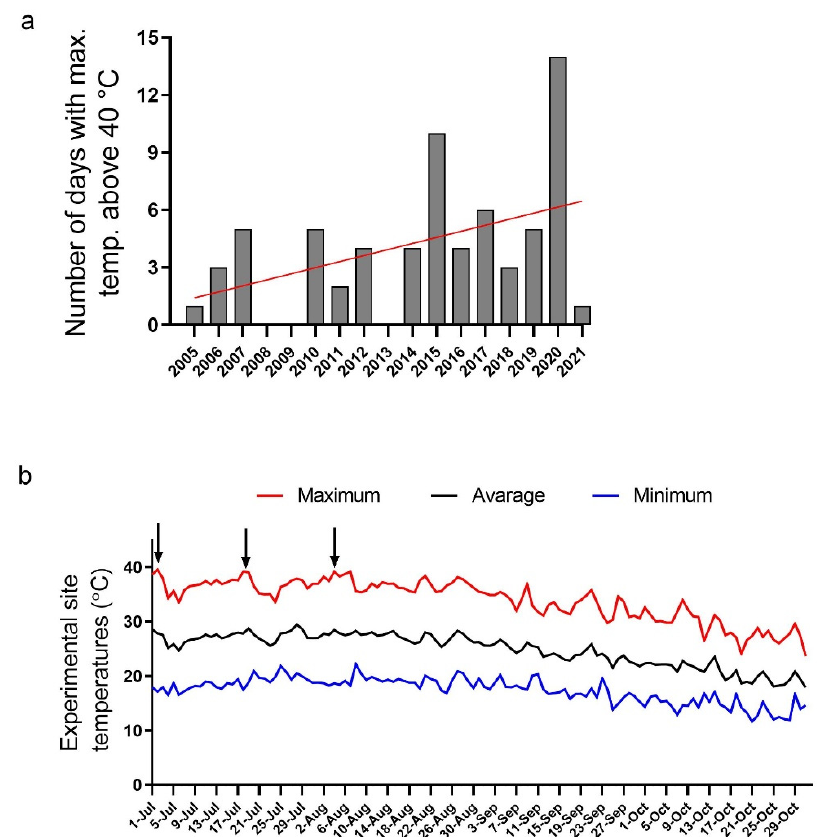
Figure 1. Increasing frequency of extreme heat waves over the last 16 years and experimental site temperatures. ( a ) Daily maximum temperatures recorded from January 2005 to October 2021 at Amiad station, close to the experimental site. The graph shows the number of days on which maximum temperature exceeded 40 ◦ C. Nonlinear regression is drawn with a red line. ( b ) Maximum, average and minimum air temperatures collected by Hobo temperature data loggers at the experimental site from beginning of July to end of October 2021. Arrows indicate days with highest air temperatures.